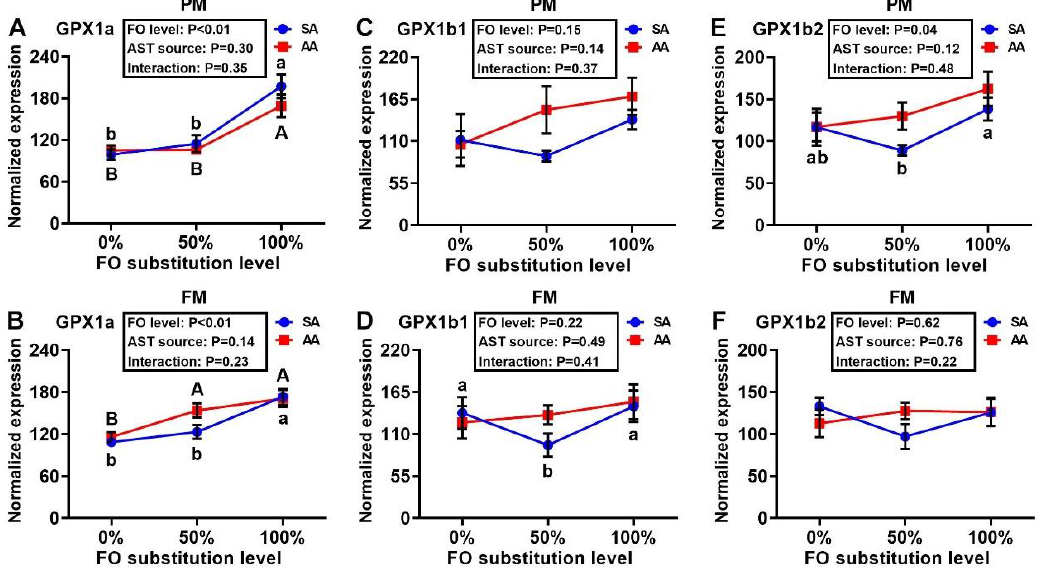
Figure 6. Effects of dietary fish oil substitution by DHA-rich microalgae and source of astaxanthin on hepatic mRNA levels of GPX1a ( A , B ), GPX1b1 ( C , D ), and GPX1b2 ( E , F ) of juvenile rainbow trout fed the plant meal- (PM, A , C , E ) and fishmeal (FM, B , D , F )-based diets. Means labelled with different letters [lowercase (a, b), synthetic astaxanthin (SA) groups; uppercase (A, B), microalgae astaxanthin (AA) groups] are different between various fish oil substitutions ( p < 0.05). The absence of different letters (a, b or A, B) between means indicates no significant differences. GPX: glutathione peroxidase. FO: fish oil. AST: astaxanthin.